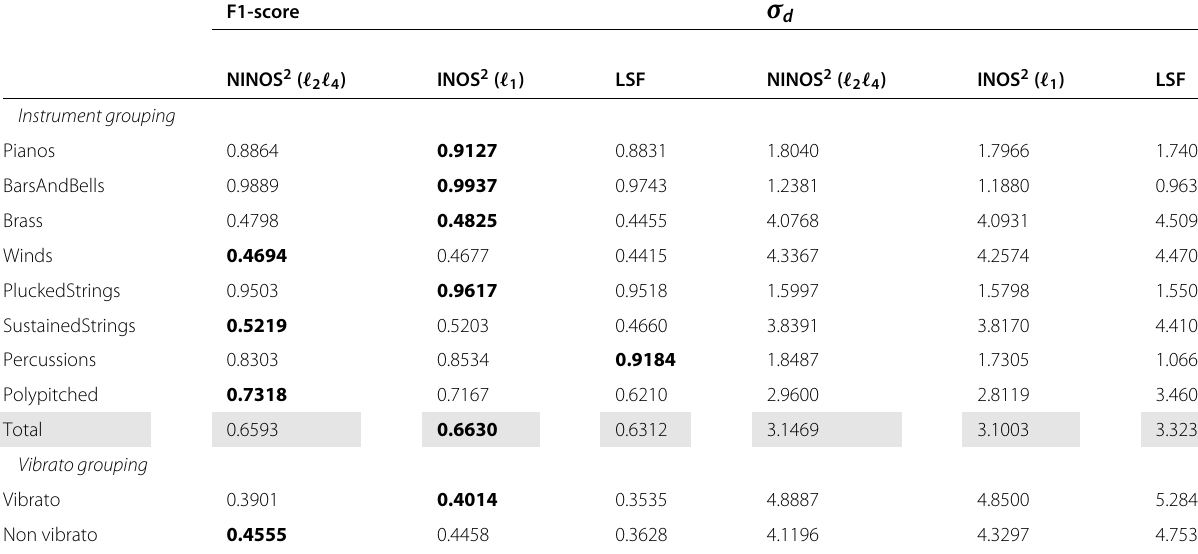
Table 5 NOD performance measures for PR8 dataset